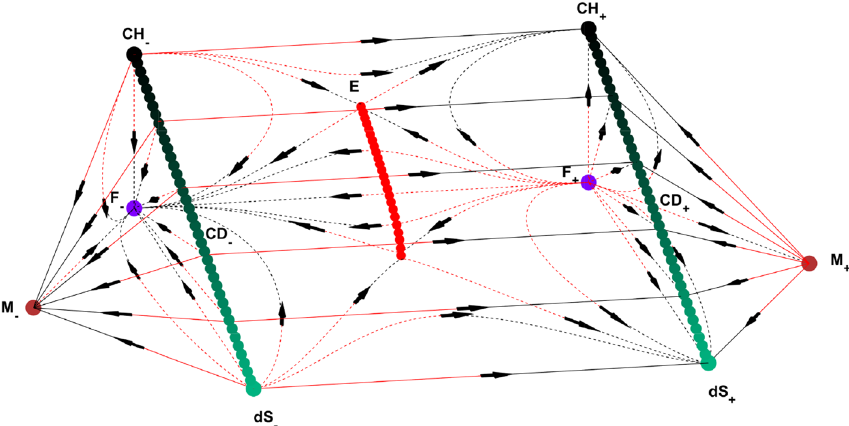
1 and γ > 2 Figure 1. State space for α 3 . Here, dots denote the solutions of the system; = 1, � � 0, � A 0, k 0 ) , Milne F, M, dS, E, CH and CD represent Flat FL solution (� = = = = 0, � � 0, � A 0, k 1 ) , de Sitter solution (� 0, � � 1, � A 0, k 0 ) , Einstein solution (� = = = = − = = = = 1, � � 0, � A 0 ) and 0, H 0 ) , Chaplygin Gas solution (� 1 √ γ , k α static solution curve ( H ′ = + = = = = = 1 0 ) , respectively. z axis corresponds � , � � � , � A 1 √ γ� , k α Chaplygin-de Sitter solution line (� + = = − = = 1 region (middle) vertical and horizontal axes correspond to (cid:31) and to (cid:31) A for all of the state space. On k = + 1 region (triangular parts on both sides), M-F and M-dS lines correspond to (cid:31) and Q , respectively. On k = − (cid:31) (cid:30) axes, respectively. The right and left parts of the state space represent expanding and contracting universes, respectively. Subscripts on equilibriums refer to the sign of H there. Lines go from red to black. (MATLAB ver. R2019b).